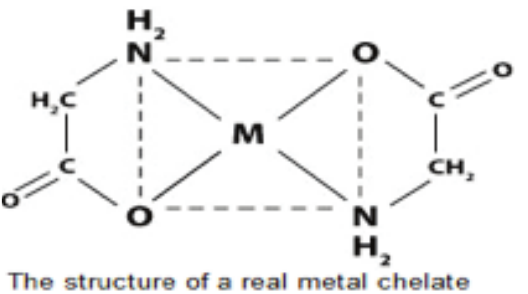
Figure 1: The structure of a real metal chelate, in which each mole- cule of metal is captured by two molecules of glycine forming two ionic and two coordinative